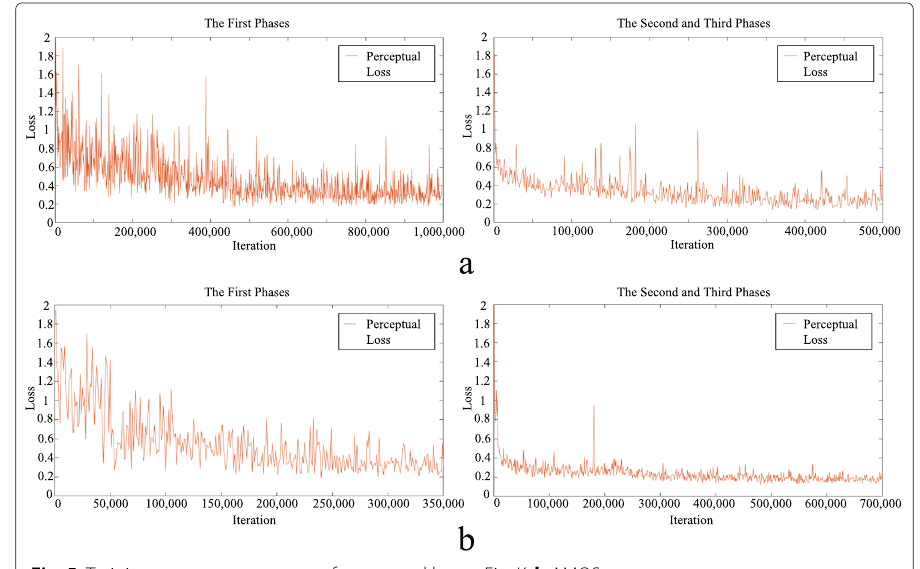
Fig. 5 Training convergence curves of perceptual loss. a FiveK. b